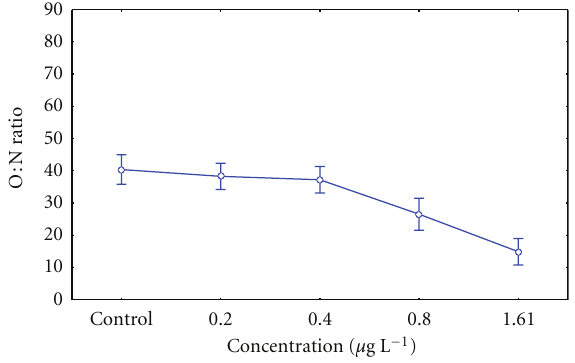
Figure 4: O :N ratio in Aulacomya ater exposed to grow sublethal concentrations of organophosphate pesticide Lorsban 4E and control group. Mean values with standard error plotted ( ∗ statistical di ff erence P < 0 .